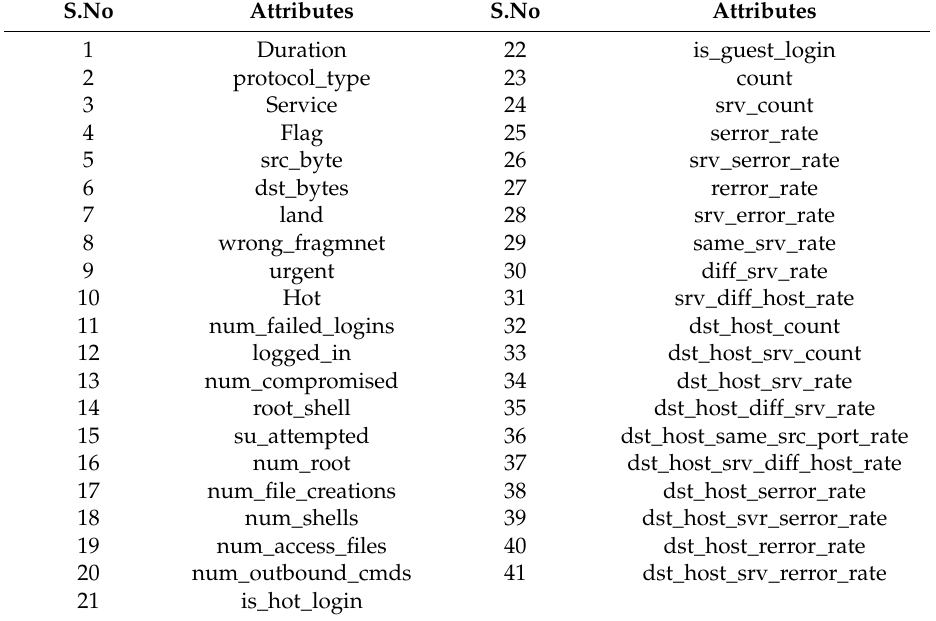
Table 2. Feature list of KDD ’99.